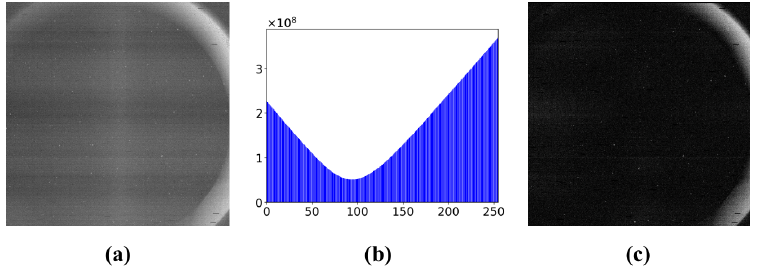
Figure 3. Saliency value calculation of star image: ( a ) star image with large-area interference; ( b ) the saliency values of the gray values; and ( c ) the resulting saliency